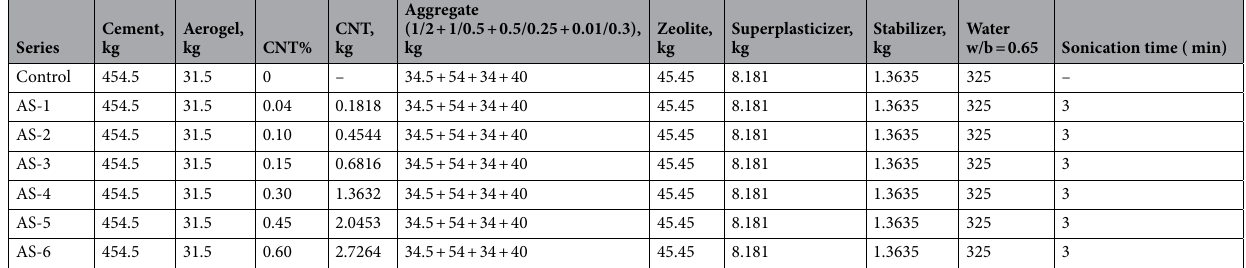
Table 4. Mixing composition of lightweight concrete samples, materials for 1 m 3 of concrete.